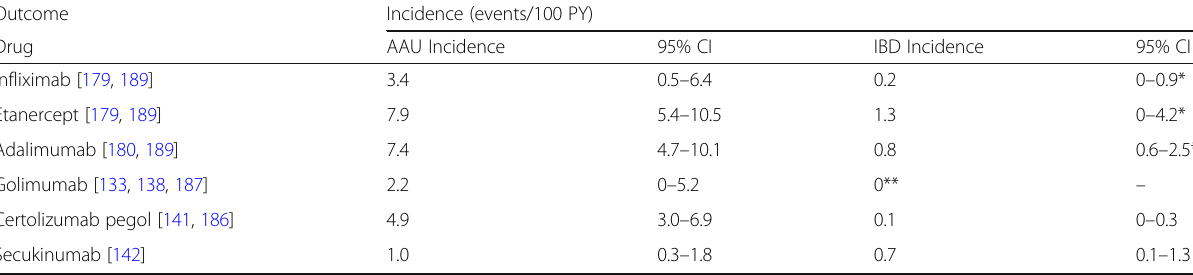
Table 6 Incidence (mean) of acute anterior uveitis (AAU) and inflammatory bowel disease (IBD) and respective 95% CIs calculated using a normal approximation. Data from different studies were pooled when the same outcomes from the same treatments were available and when they referred to doses and/or regimens approved in Brazil. * 95% CI reported by the authors of the original study. ** No new case or reactivation was reported in the study with golimumab IV. The incidence of this event was not described in studies with SC golimumab